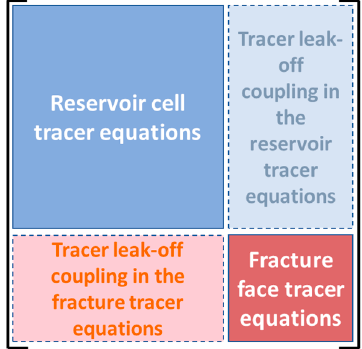
Figure 2. Matrix structure for the coupled reservoir and fracture domain tracer equations.